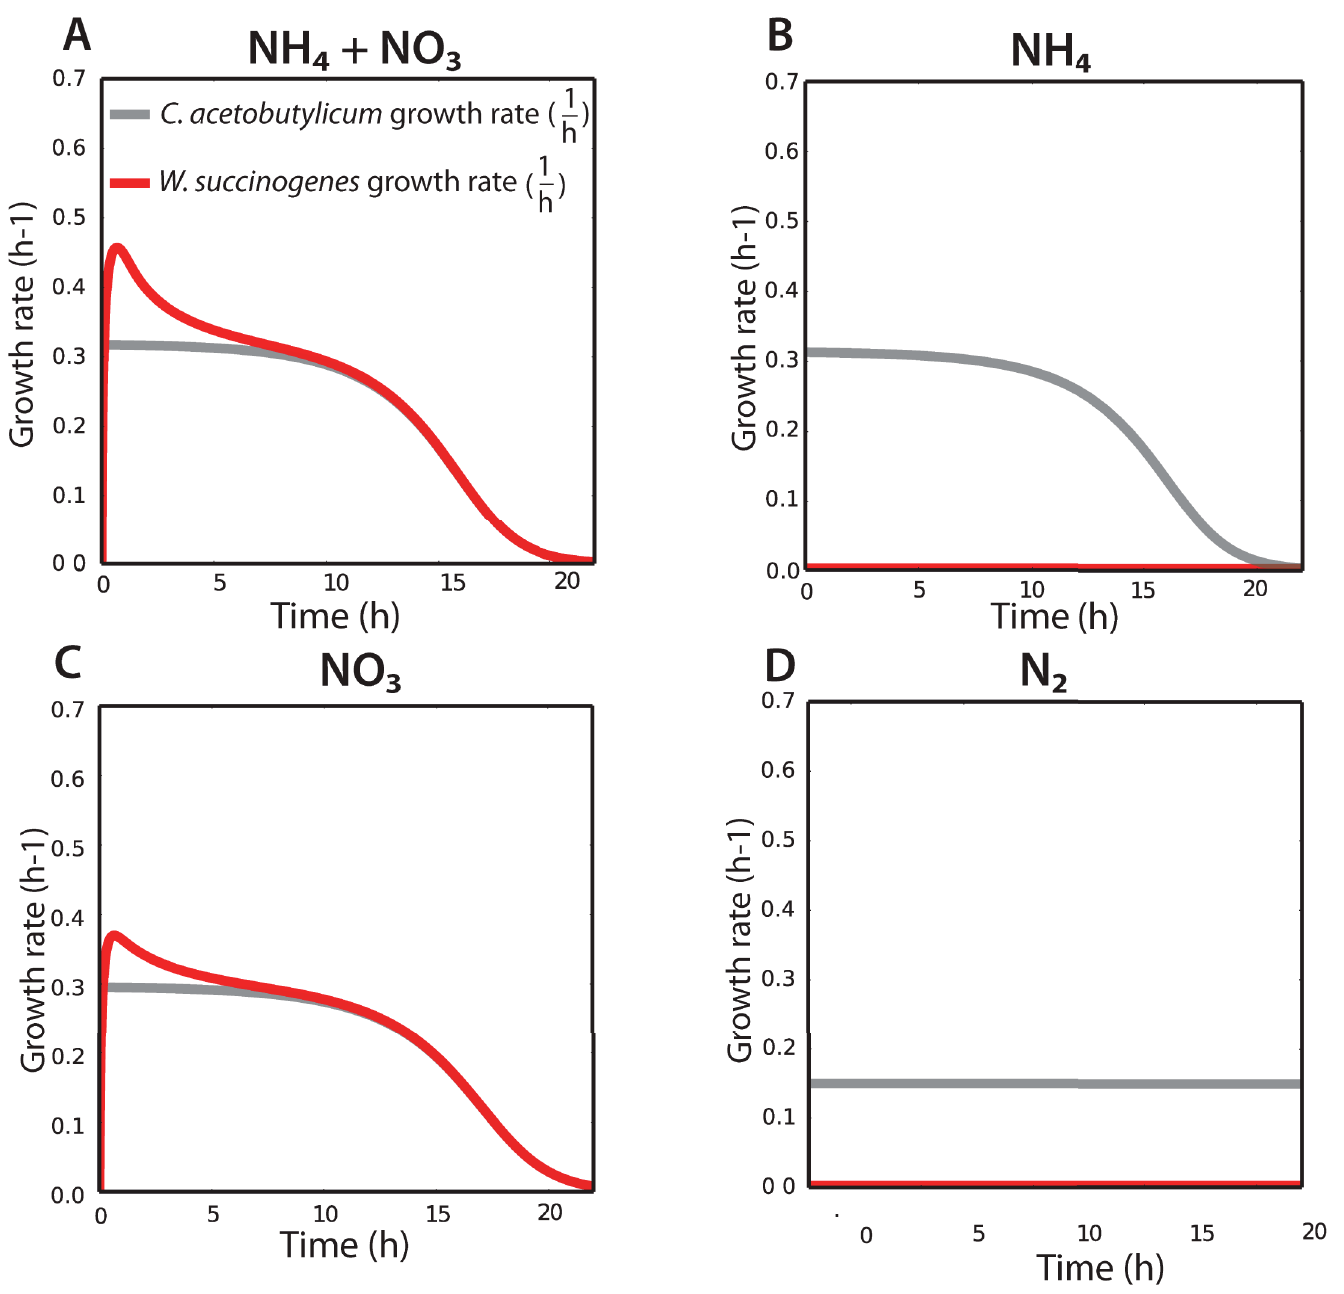
Fig 4. Growth of W. succinogenes was limited by the growth-rate of C. acetobutylicum , based on the inferred growth-rates. Balanced growth was observedafter 10 hours of cultivationin the NH 4+ + NO 3- ( A ) and NO 3- conditions ( C ). No growth of W. succinogenes was simulatedin the NH 4+ (B) and N 2 conditions( D